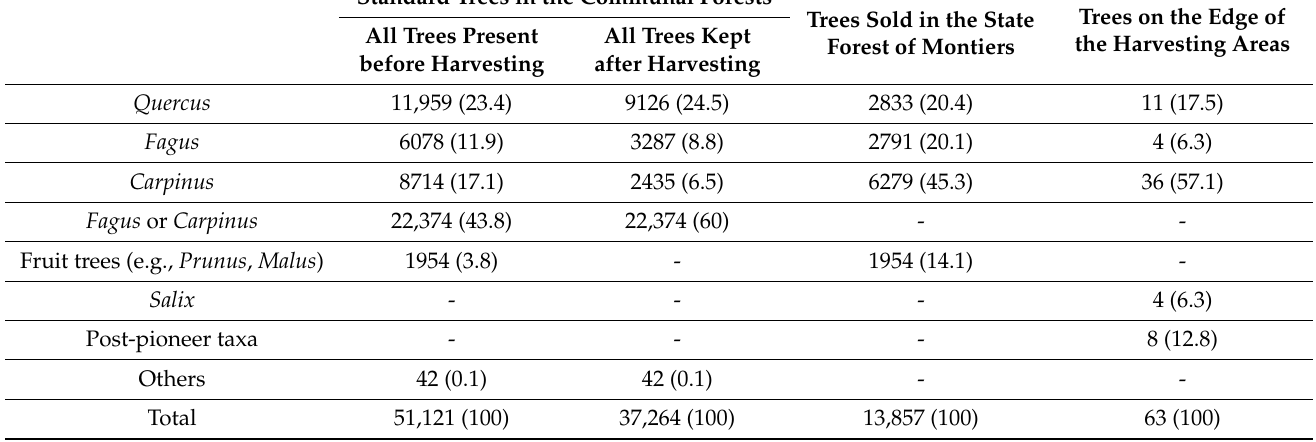
Table 3. Archive information for the period from 1783 to 1791 on tree harvesting in communal forests, timber trading in a state forest and the trees limiting the harvesting areas. The values shown are total number of trees and, in brackets, relative frequency. “Post-pioneer taxa” groups the classes representing less than 5% and include Prunus avium , Populus tremula , Sorbus torminalis , Acer spp. and Acer platanoides . Standard Trees in the Communal Forests Trees on the Edge of Trees Sold in the State All Trees Kept the Harvesting AreasAll Trees Present Forest of Montiers before Harvesting after